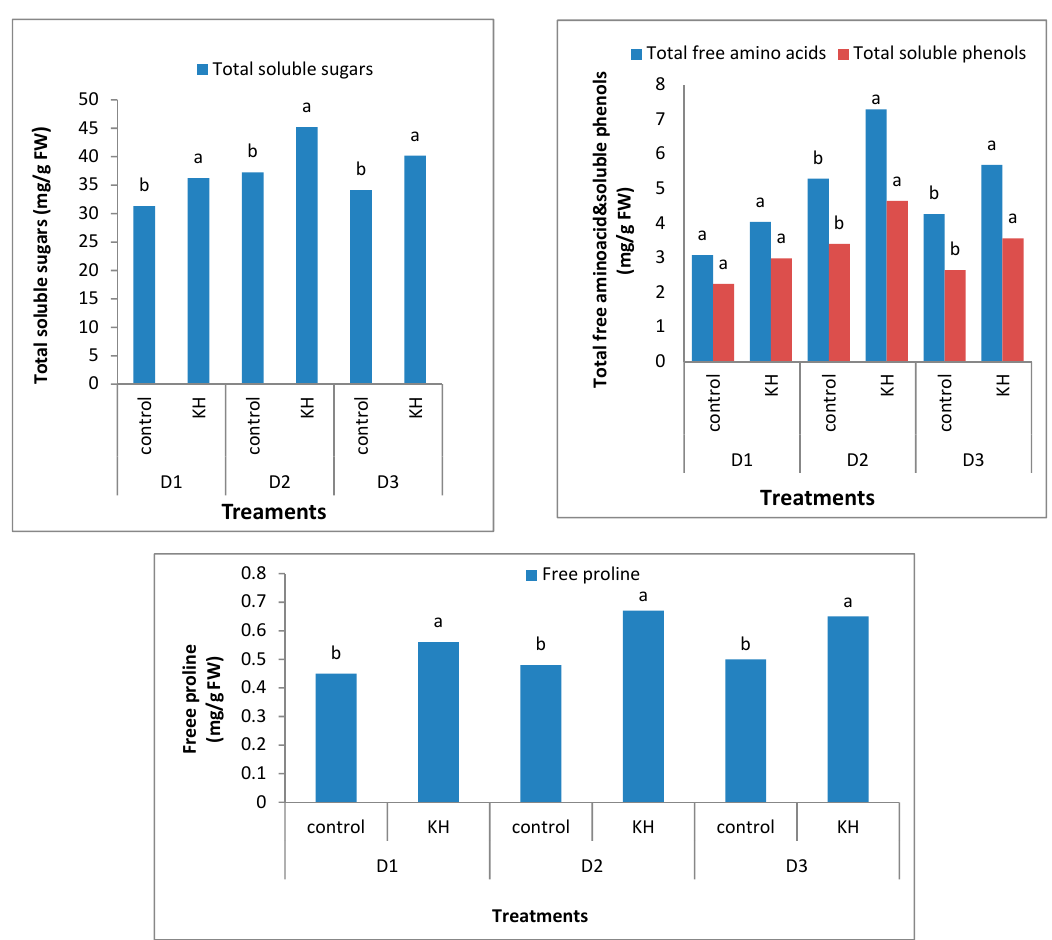
Figure 3. Effect of potassium humate (KH) application and planting density treatment on total soluble sugars, free amino acids, soluble phenols and proline content (mg/g FW) of Vicia faba L. plants. For each parameter, treatments followed by the same letter are not significantly different at p ≤ 0.05.